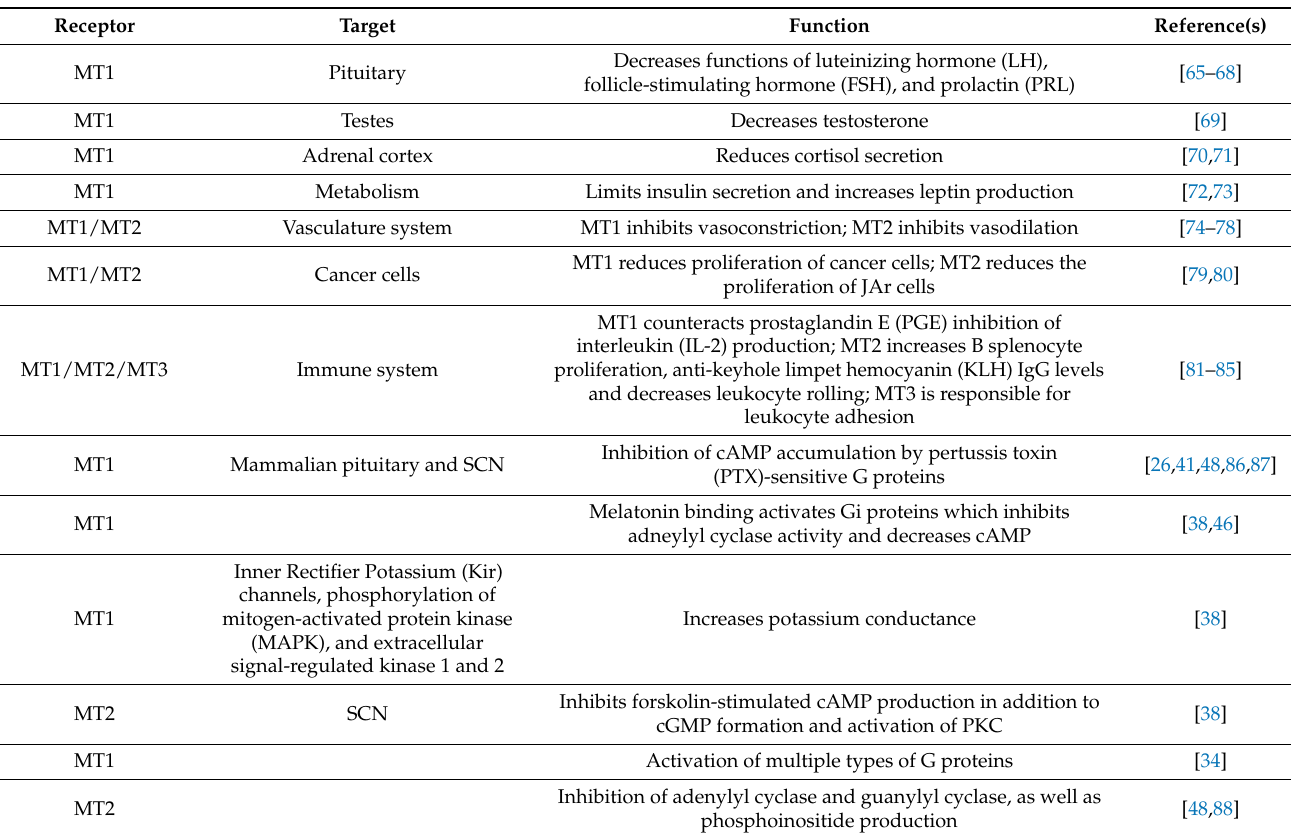
Table 1. Melatonin receptor